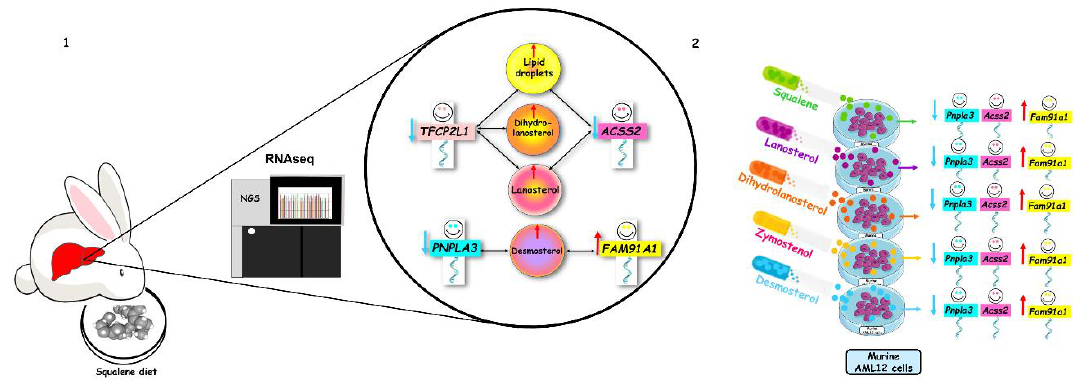
Figure 9. Overview of experimental approaches and main findings. (1) In vivo dietary intervention in rabbits and (2) cell culture incubation using AML12 cell line. NGS, next generation sequencing.